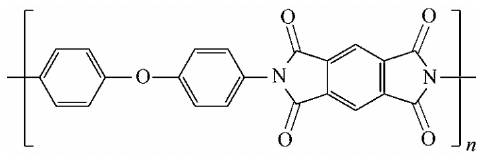
Figure 1. Molecular structure of polyimide.